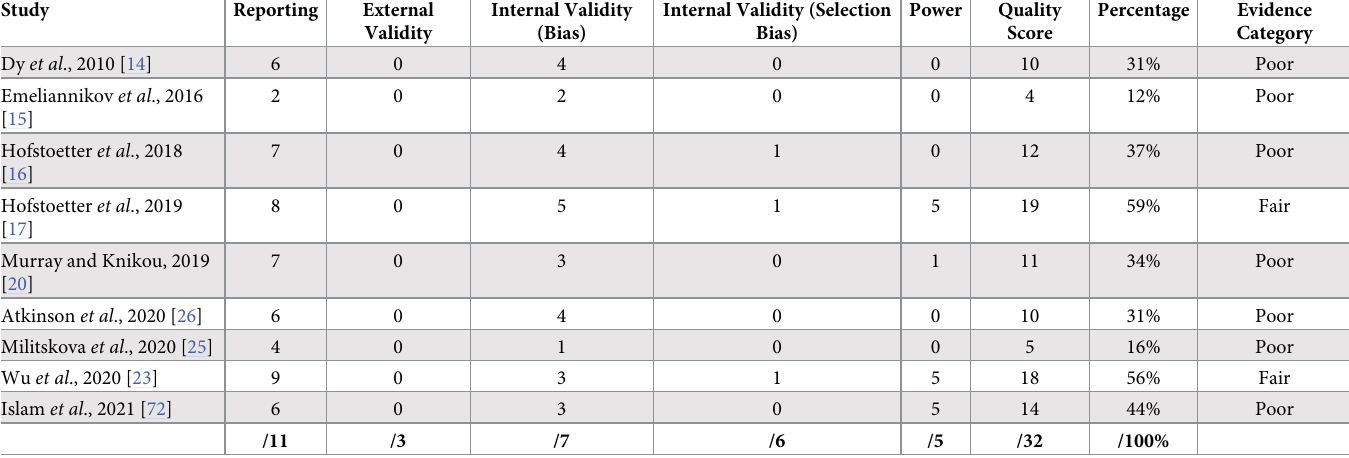
Table 4. Results from the quality appraisal of neurophysiological investigations using the Down’s and Black Checklist. Quality of Evidence Assessment–Neurophysi- ological Investigations.